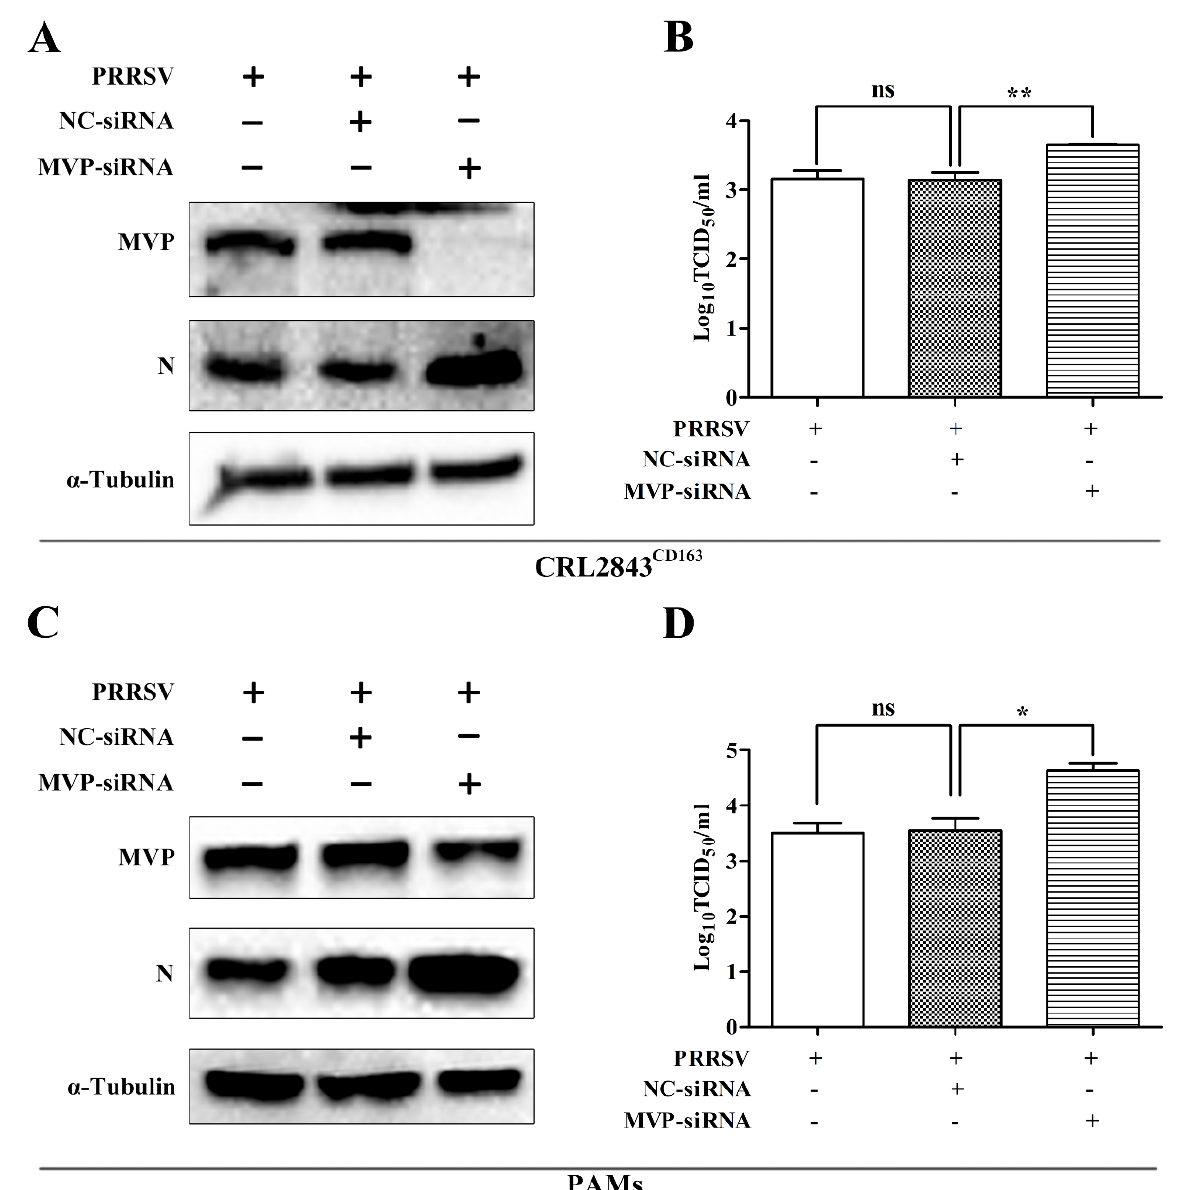
Figure 4. MVP knockdown promoted PRRSV replication in CRL2843 CD163 cells and PAMs. CRL2843 CD163 cells or PAMs were transfected with NC − siRNA or MVP − siRNA for 12 h or 36 h followed by infection with GD-HD PRRSV at an MOI of 1 or 0.1 for 48 h or 24 h, respectively. The protein expression levels of MVP and PRRSV N were detected by Western blot ( A , C ). Virus titers in cell supernatants were measured by TCID 50 . ( B , D ) The α -tubulin was used as an internal loading control in Western blot analysis. Data from three independent experiments are expressed as the means ± SD. The analysis of differences between the means was performed using ANOVA and is marked by ns (no significant), * ( p < 0.05), and ** ( p < 0.01).